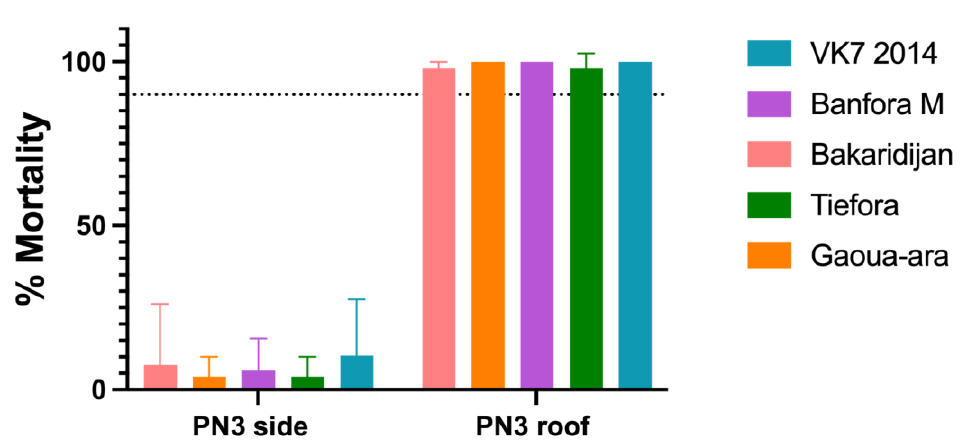
Figure 5. Mortality following exposure to Permanent 3.0 LLINs (PN3) in cone bioassays. Mortality rates % 24 h after exposure. Minimum sample size n = 50. Error bars represent 95% confidence in- tervals.